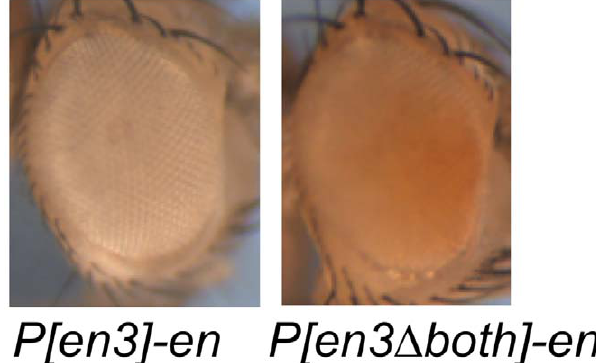
Figure 1. P-constructs used in homing experiments. Arrow shows the direction and start of transcription. L, loxP site. F, FRT site. P[en3R] is from [21] (called P[en1] in that study). P[en3] and P[en3 D both] are from [18].